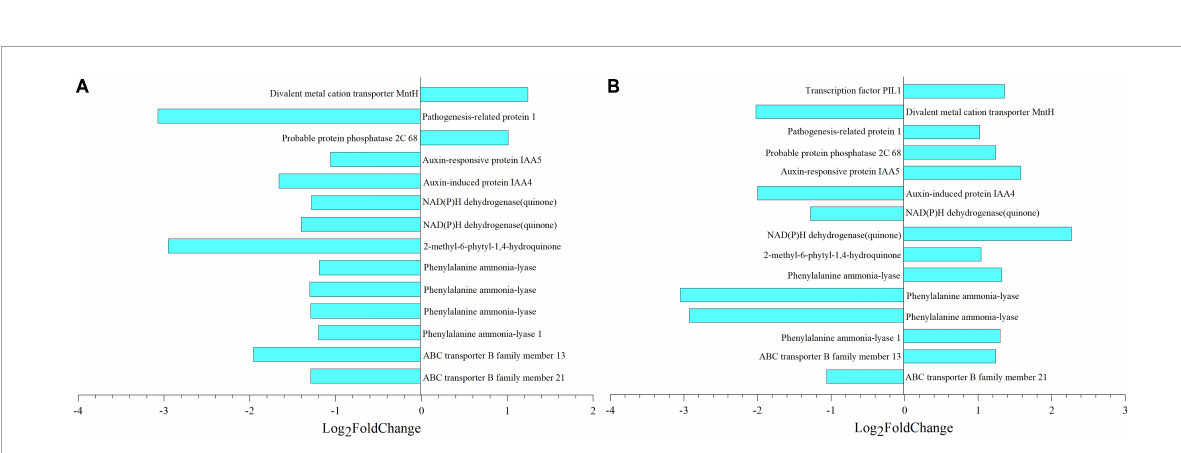
FIGURE10 Metabolic and gene expression changes associated with seed coat development of E. nutans . Column diagram representing the accumulation of key metabolites that were significantly associated with DEGs. (A,B) Differential multiples of key genes between 8 vs. 18 dpa and 8 vs. 28 dpa, respectively. 1,753, thiamine; 123, salicylic acid